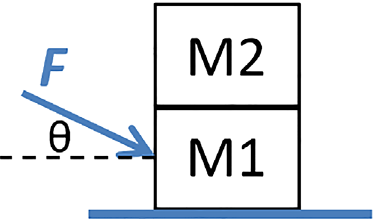
FIG. 12. Diagram provided in the prompt for version C of week 7, level 1 problems.